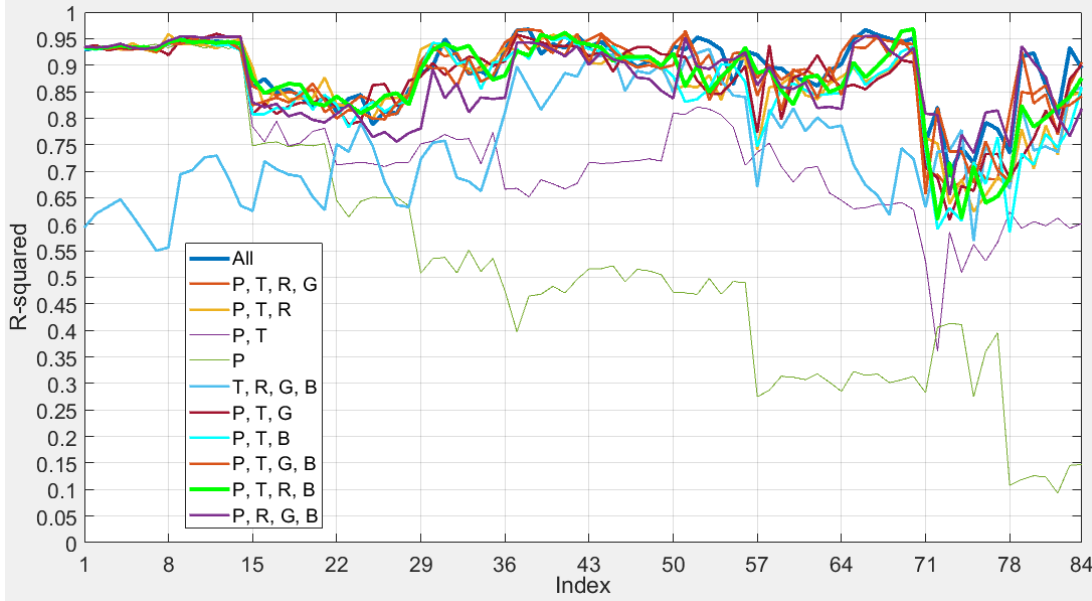
Figure 14. R 2 values for neural network regression models for P 0 with varying input variables.